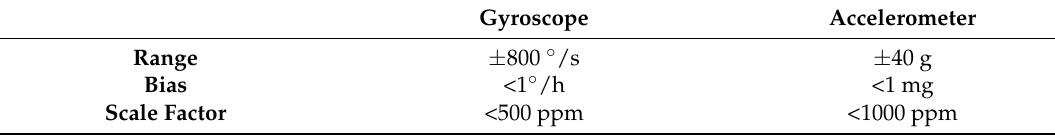
Table 2. The characteristics of LCI-1 IMU.